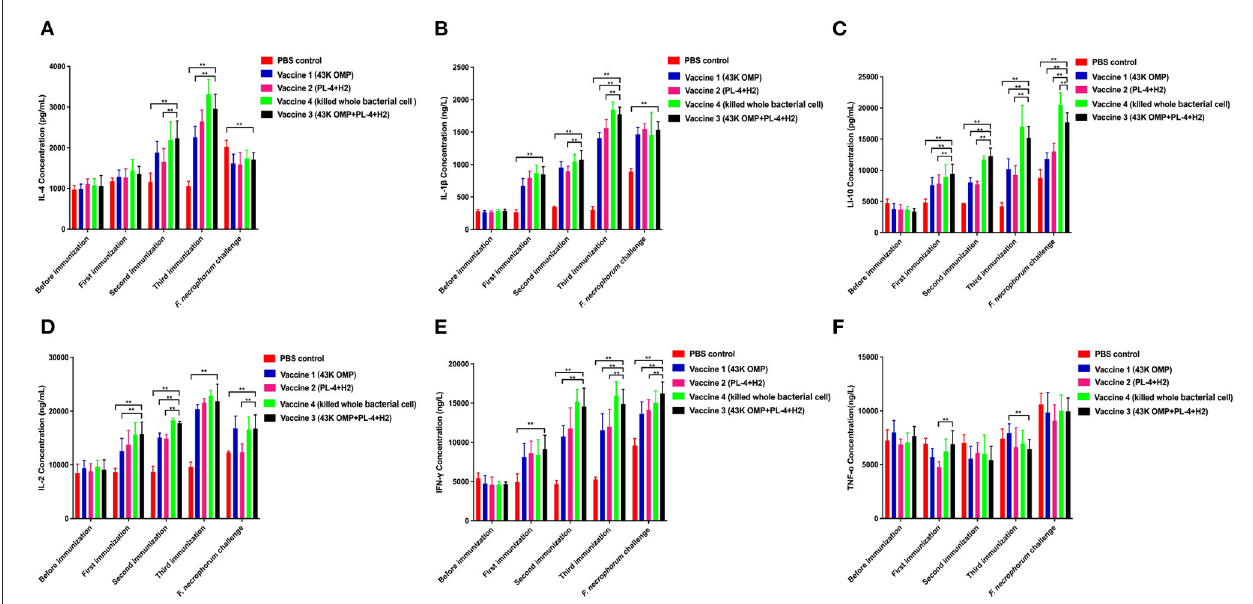
FIGURE 1 | Detection results of cytokines in mouse serum. (A) Detection of IL-4 in mice. (B) Detection of IL-1 β in mice. (C) Detection of IL-10 in mice. (D) Detection of IL-2 in mice. (E) Detection of INF- γ in mice. (F) Detection of TNF- α in mice. Data are represented as mean ± SEM of three replicates. *A result significantly different (* P ≤ 0.05 and ** P ≤ 0.01) from their respective control. All groups of mice serum were collected the day before the next immunization for cytokine